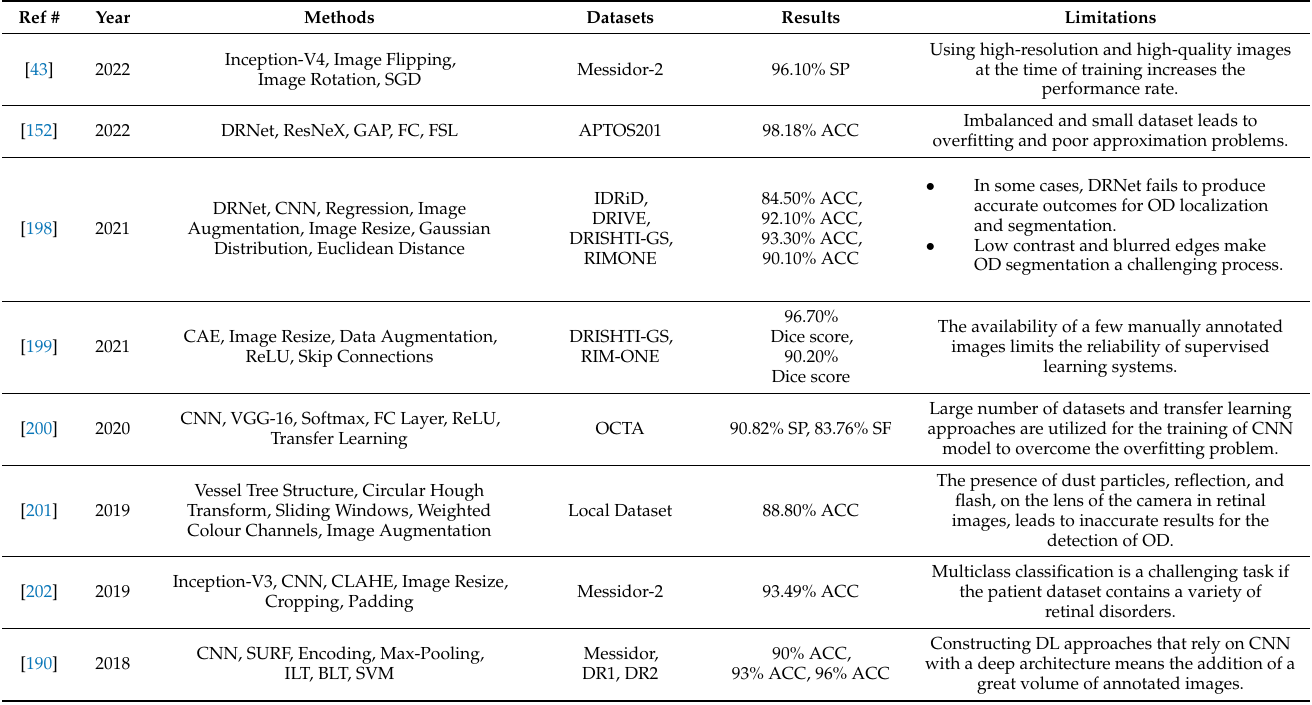
Table 8. Limitations in existing